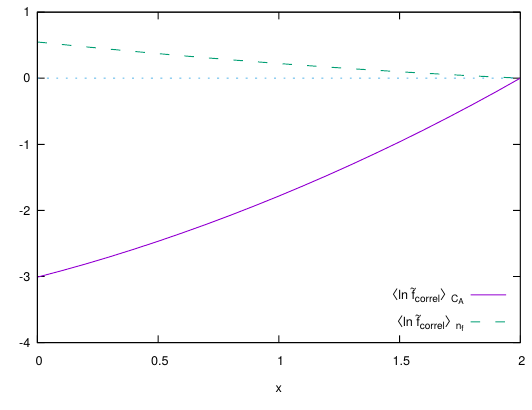
Figure 1 . The corrections h ln ~ f correl i C